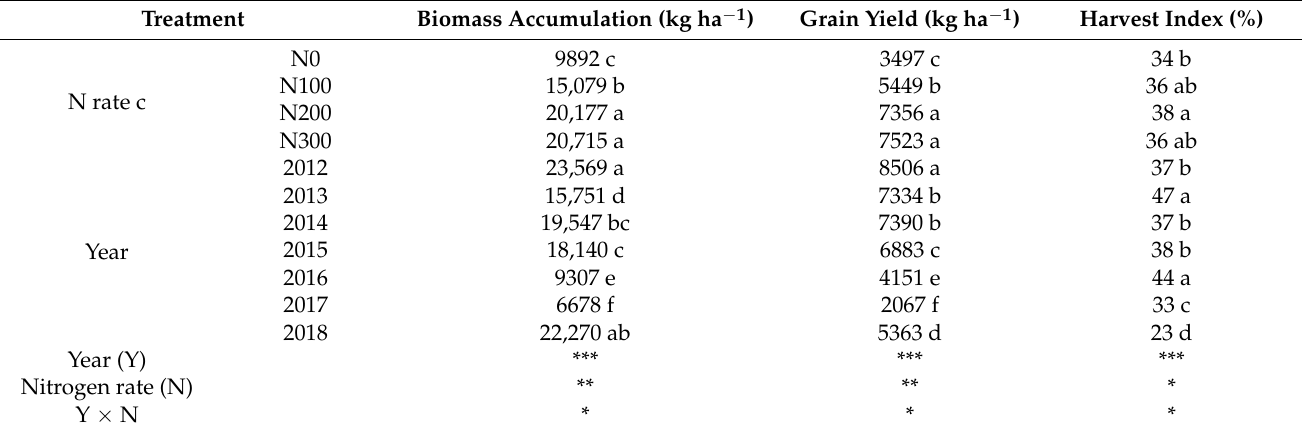
Table 3. Effects of four rates of nitrogen (N) application and growing seasons on biomass accumu- lation, grain yield, and harvest index of maize. Treatment Biomass Accumulation (kg ha − 1 )